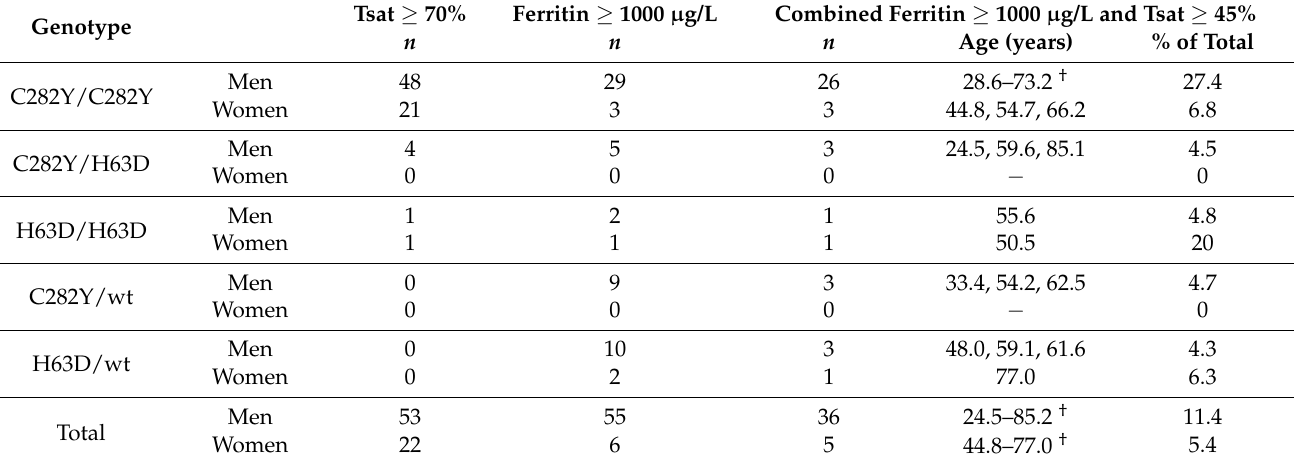
Table 5. Proportion with significantly elevated ferritin and transferrin saturation (Tsat) at referral.